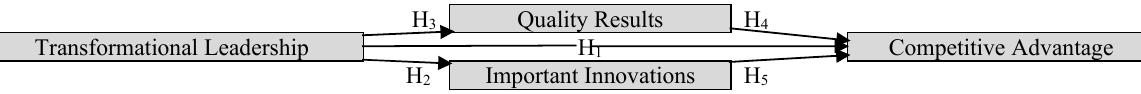
Fig. 1. Hypothesised Model (Source: Author